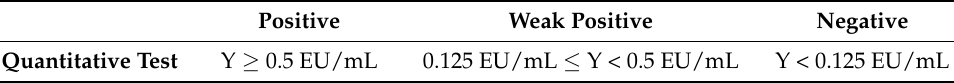
Table 2. Determination criteria for quantitative testing. Positive Weak Positive Negative Quantitative Test Y ≥ 0.5 EU/mL 0.125 EU/mL ≤ Y < 0.5 EU/mL Y < 0.125 EU/mL